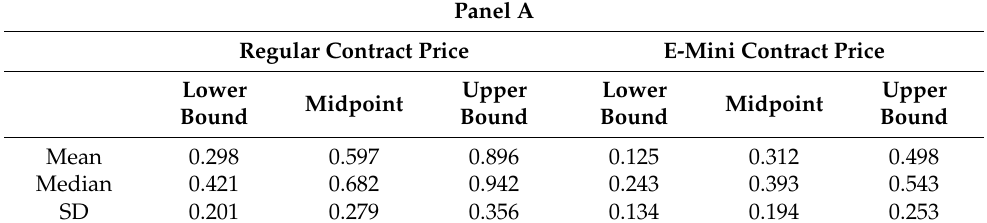
Table 5. Robustness check of information share: Gonzalo–Granger weights. Panel A Regular Contract Price E-Mini Contract